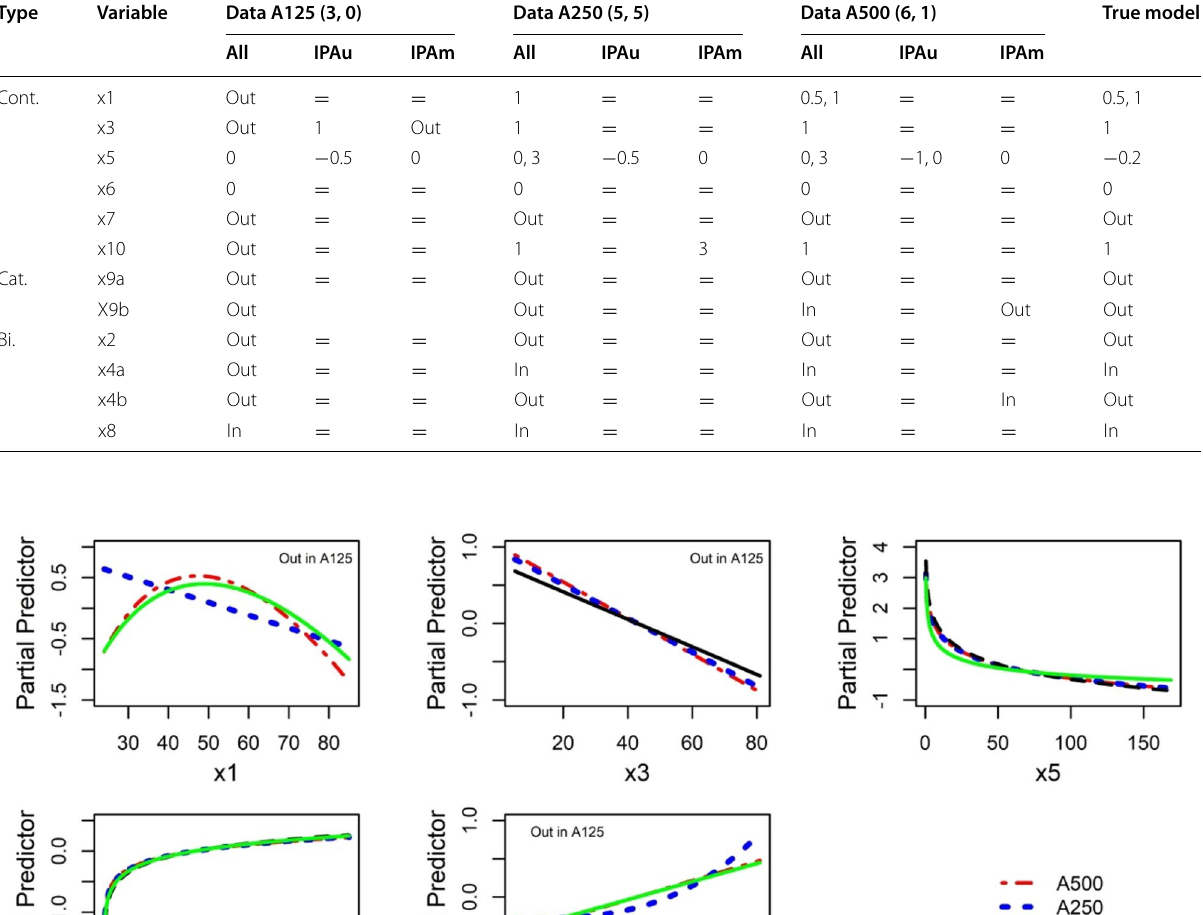
The elimination of five IPs did not affect the selection of variables but changed some of the power terms of con- tinuous variables. For n 500, the selected MFP models = agreed well to the true model. Selected functions for x1 (Fig. 7) best illustrate the significant impact of the sam- ple size. The variable was eliminated when n 125, a = linear function was selected when n 250, and an FP2 = function that was close to the true function was selected when n 500. =